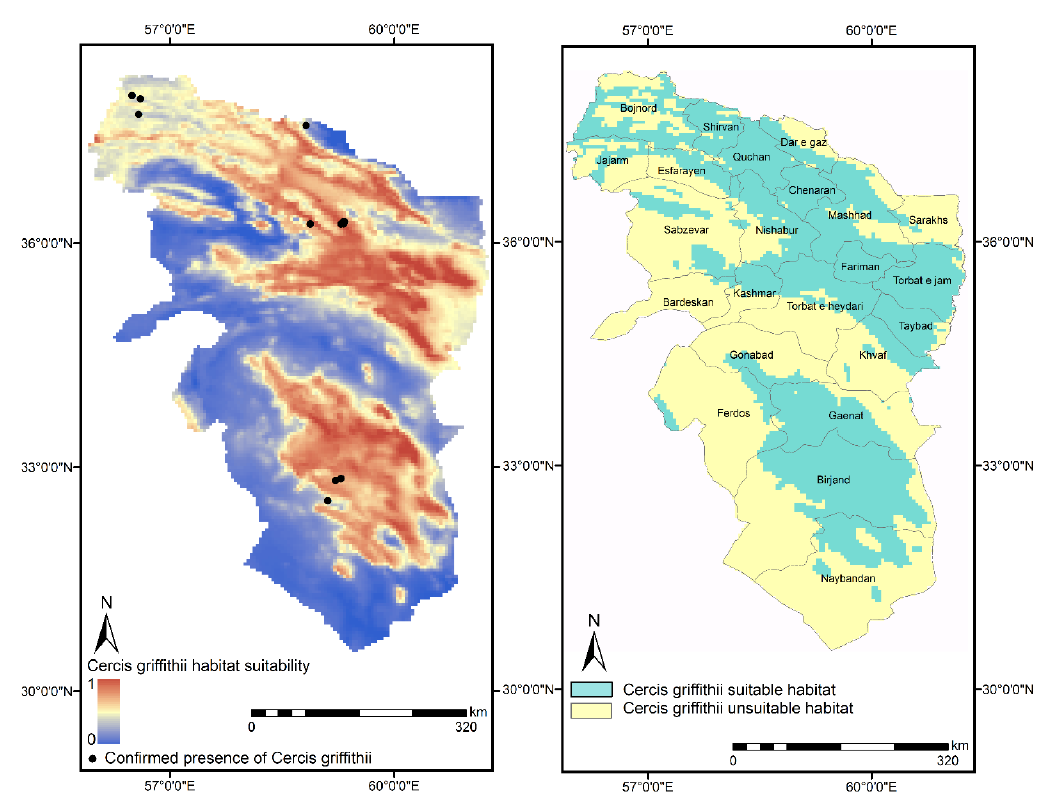
Fig. 4: Habitat suitability of Cercis griffithii and its suitable habitats in the cities of Khorasan